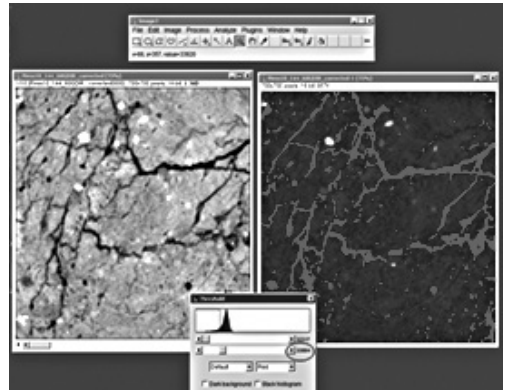
figure 4. interface of the Image J program to determine the threshold value to define the limits of image pores. real image with contrast (right), pores represented by the color gray, aiming to evaluate the threshold value (left). Figure 5. classification of pores based on shape table 1. classification of pores regarding shape and